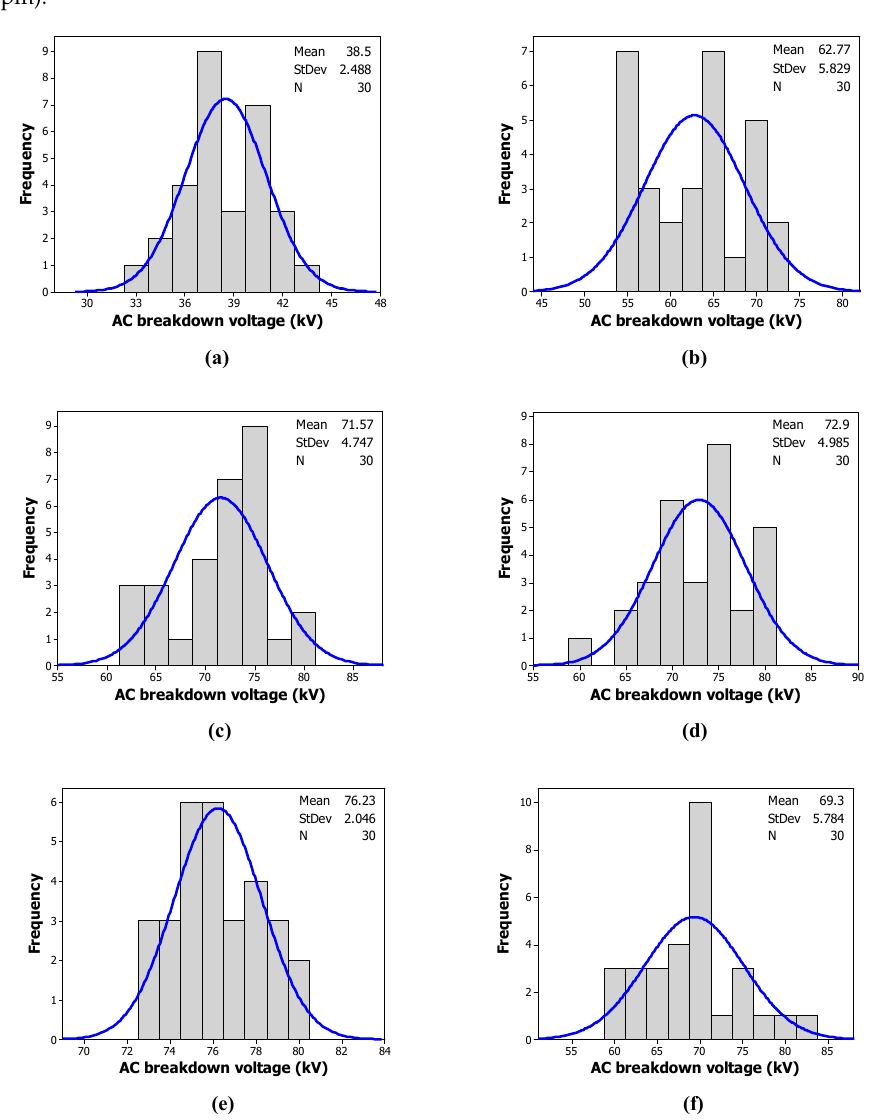
Figure 9. Frequency of the breakdown voltage of: ( a ) the MO; ( b ) the MO/CH 3 I (200 ppm); ( c ) the MO/CH 3 I (300 ppm); ( d ) the MO/CH 3 I (400 ppm); ( e ) the MO/CH 3 I (500 ppm); ( f ) the MO/CH 3 I (600